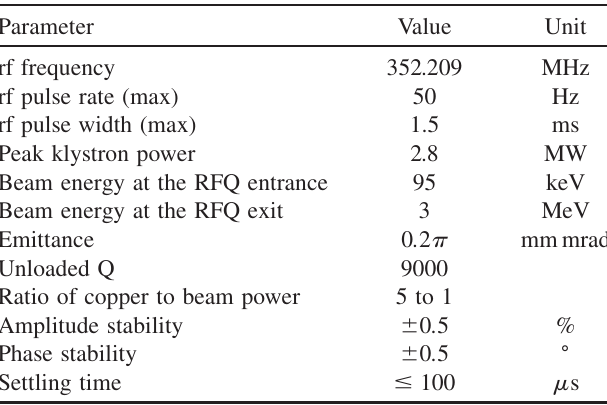
TABLE I. Tentative list of the properties of the ESS-Bilbao RFQ